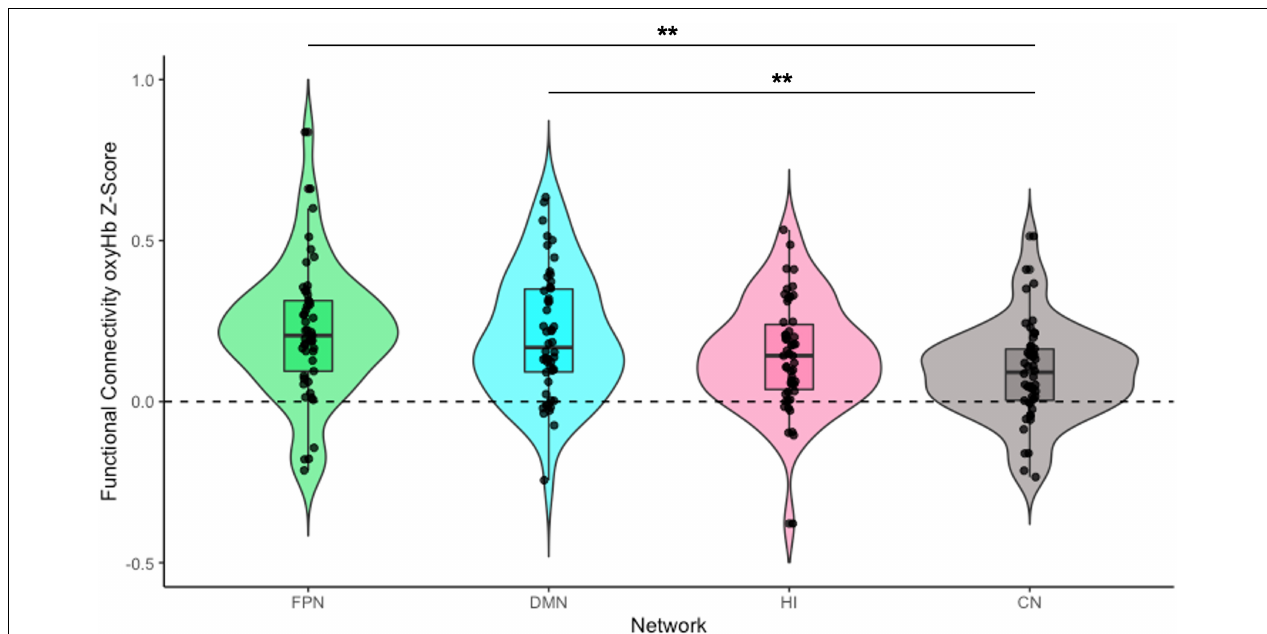
FIGURE 3 | Infant functional connectivity by network at 5 months. This figure shows the average levels of functional connectivity (oxyHb) for each network. The boxplot horizontal lines from bottom to top reflect values for the lower quartile, median, and upper quartile, respectively. FPN, fronto-parietal network; DMN, default mode network; HI, homologous-interhemispheric connections; CN, control network. N = 50. ** p <